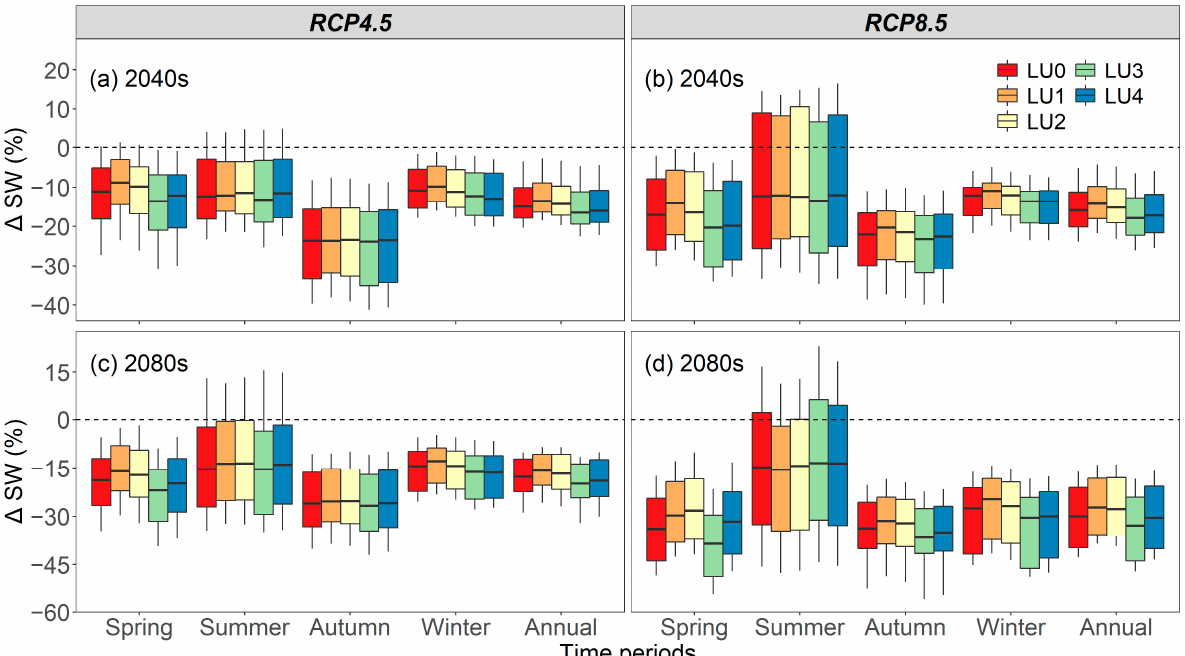
Figure 8. Projected seasonal and annual changes in ET (%) for LU0 − LU4 in the 2040s and 2080s under both RCPs estimated from 34 GCMs compared to the baseline period. Data displayed are changes in the 40 − year averages for each of the 34 GCMs. The lower and upper whiskers show the 10th and 90th percentiles; box boundaries show the 25th and 75th percentiles; the black line within each box marks the median values.